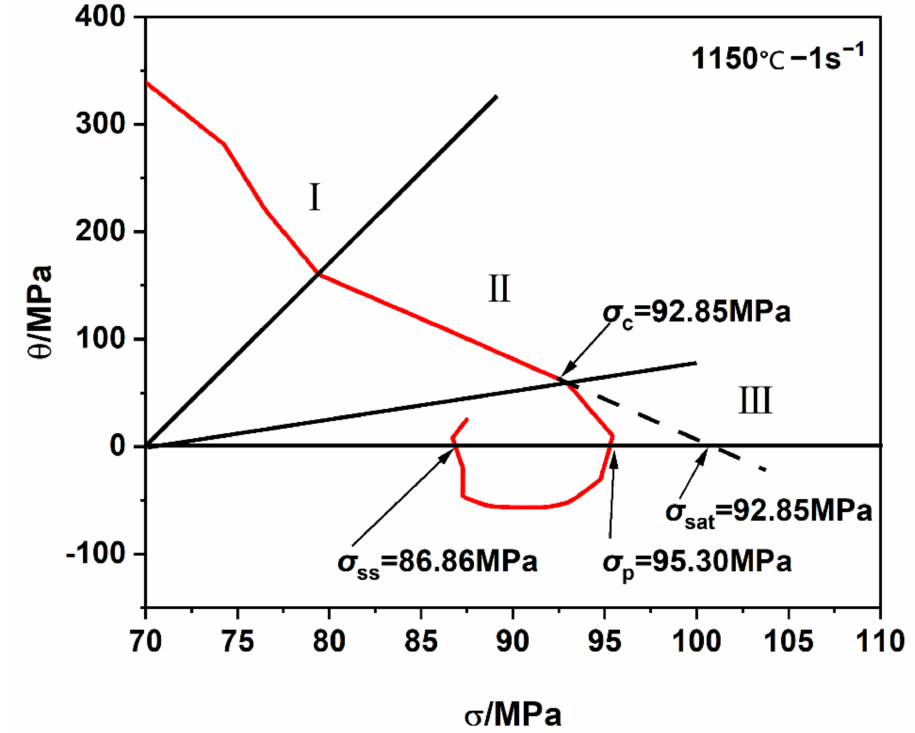
Figure 4. Work hardening rate ( θ ) relative to the flow stress ( σ ) at a deformation temperature of 1150 ◦ C and a deformation rate of 1 s − 1